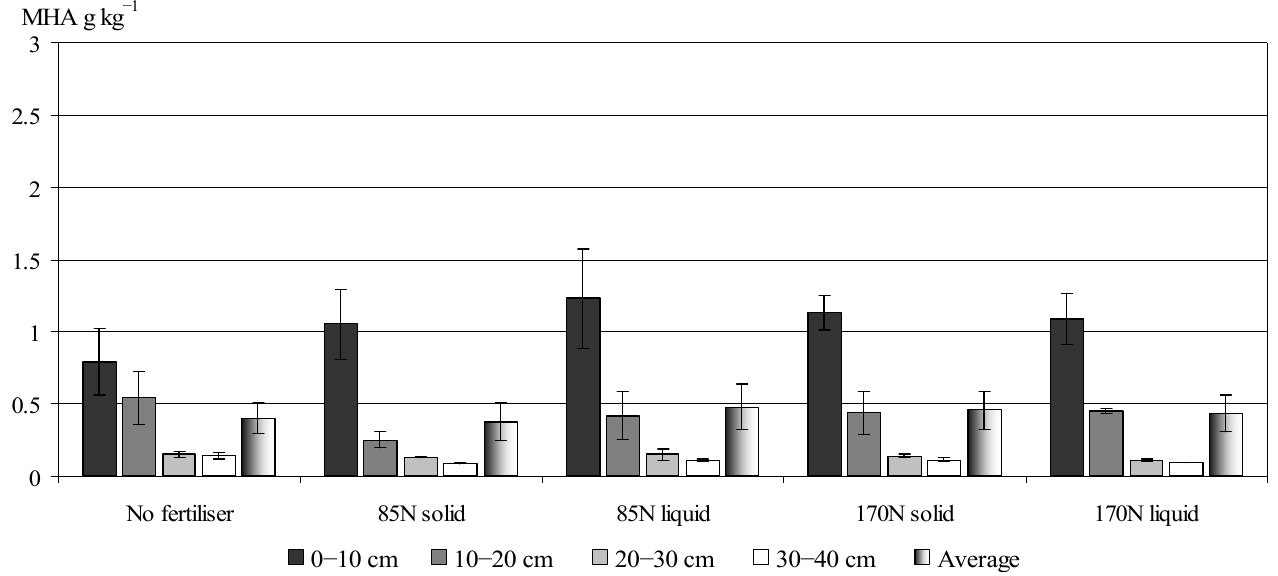
Figure 17. MHA content in grassland in Retisol, 2019 .